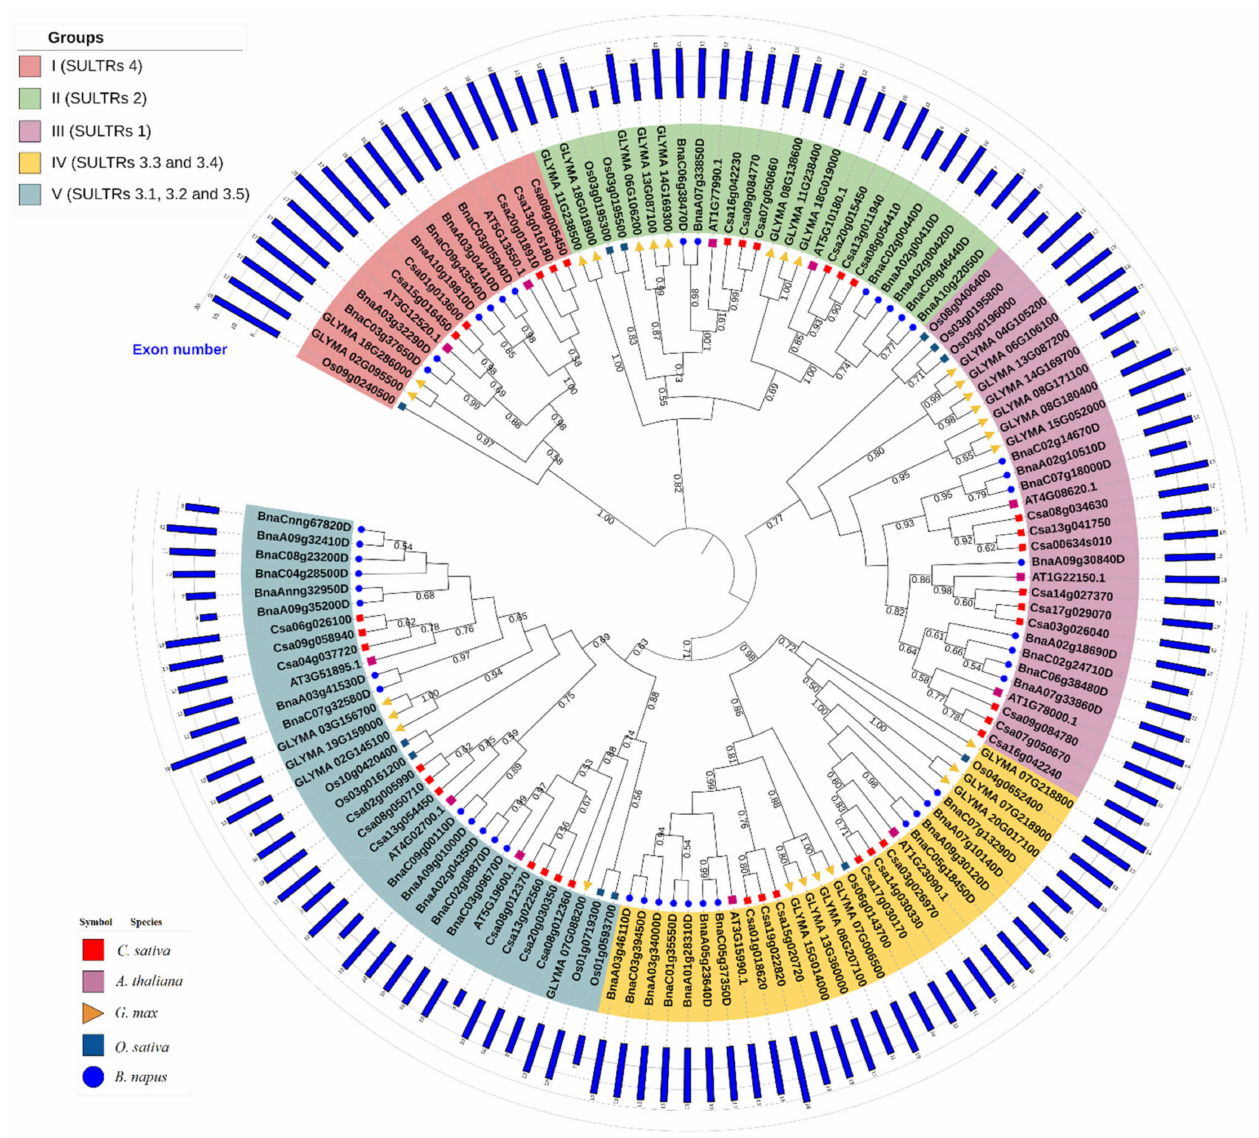
Figure 1. The phylogenetic tree of the SULTRs from Camelina sativa, Brassica napus, Arabidopsis thaliana, Glycine max , and Oryza sativa . The exon numbers for the SULTR coding genes are shown in the blue bar (more details related to the gene structures are provided in Table